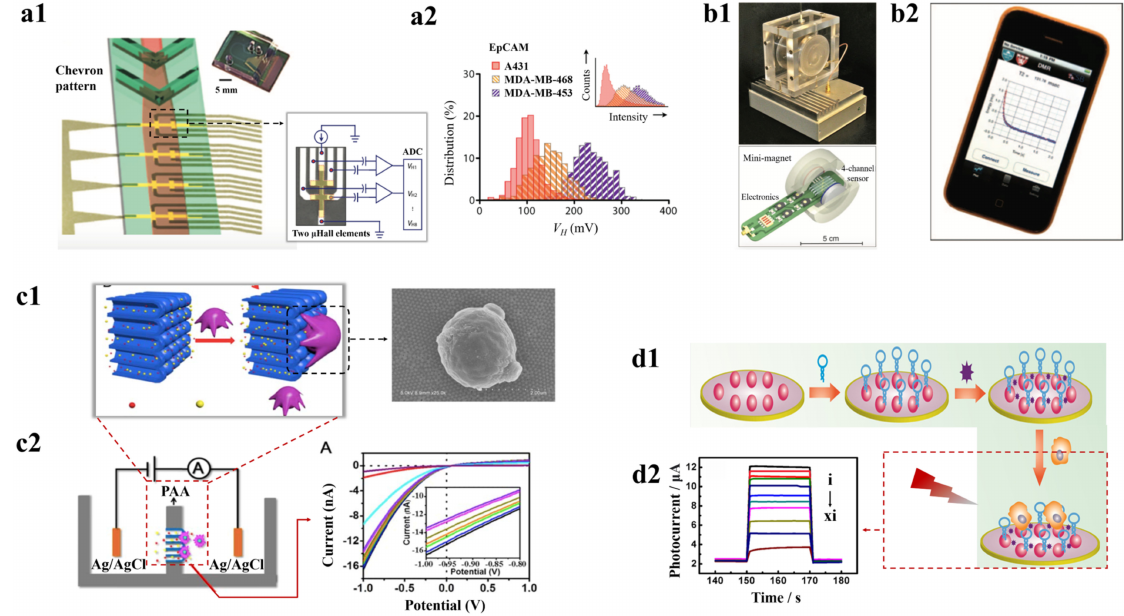
Figure 6. The different strategies for the detection of CTCs using NPs (part-II). ( a1 ) shows the micro- Hall detector integrated with the microfluidic device. The zoomed image represents the